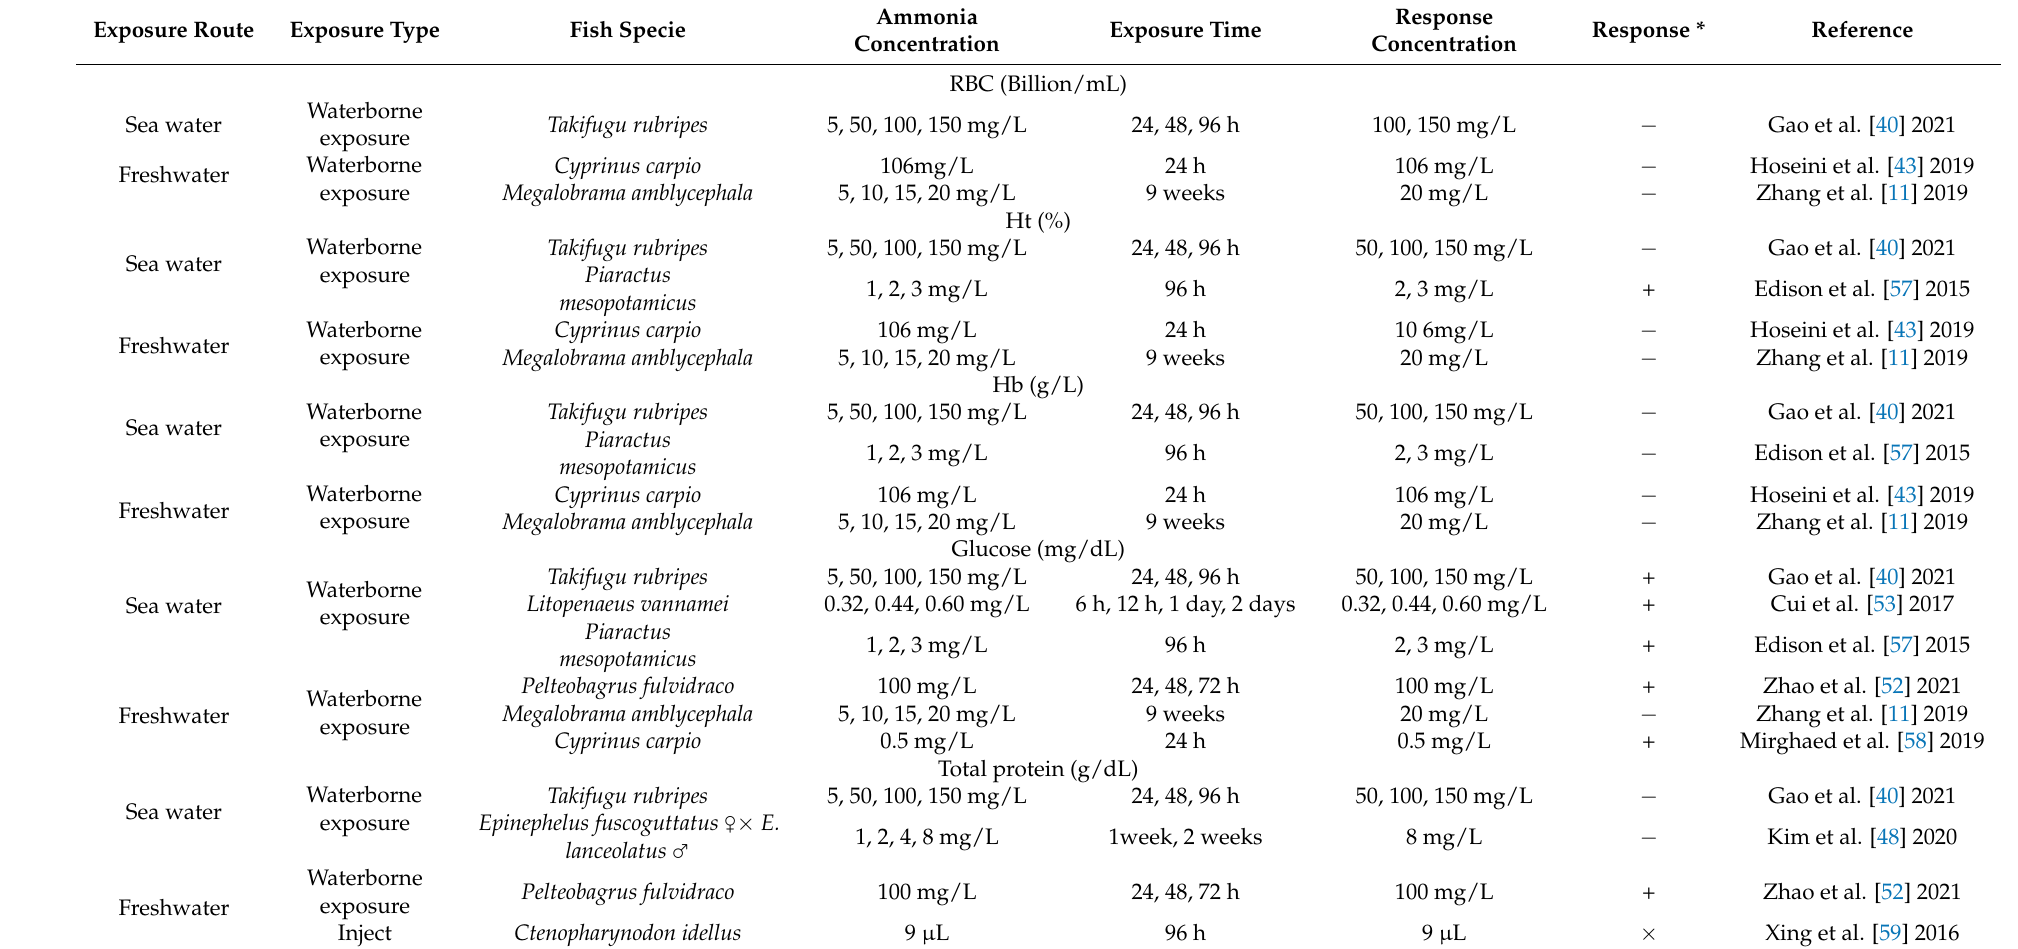
Table 1. Hematological parameters in fish exposed to